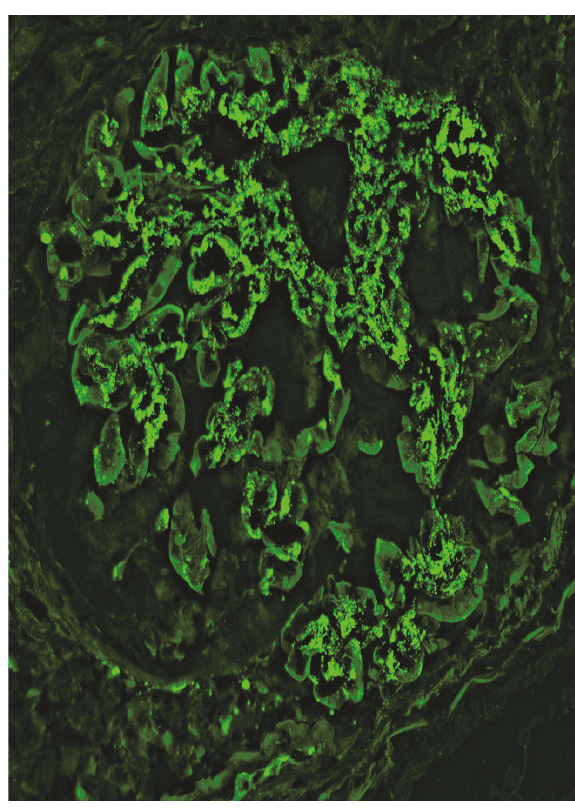
Figure 4: Global 3+ mesangial deposit of complement component C3 is present (immunofluorescent, x 400).